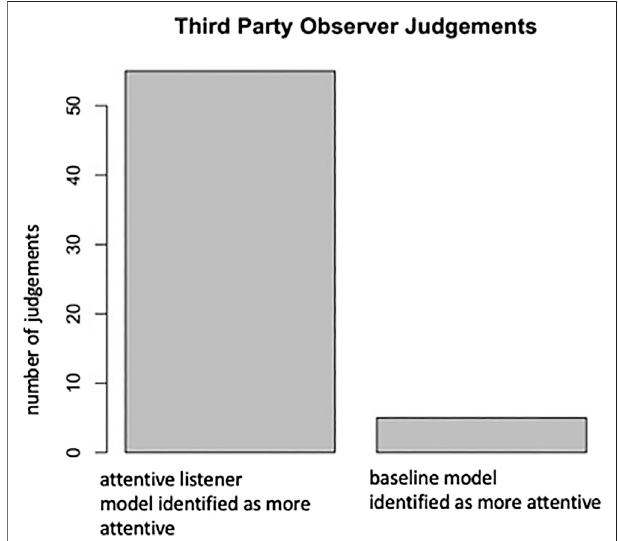
FIGURE 9 | This fi gure indicates the number of cases in which the third- party observers identi fi ed the attentive listener model, respectively, the baseline model as more “ attentive.